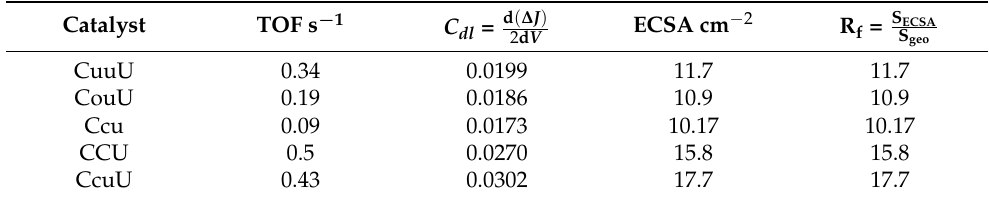
Table 3. Account of TOF alkaline seawater and electroactive sites of the as synthesized materials.